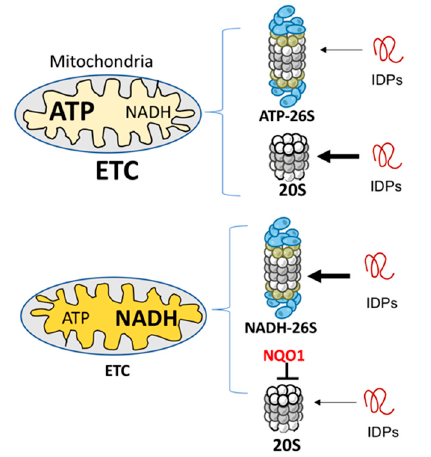
Figure 4. Mitochondria physiology and IDP degradation. Mitochondria with efficient electron transfer chain (ETC) activity ( upper ) generate a high level of ATP and low level of NADH. An opposite picture is obtained with mitochondria with low, or malfunctioning ETC ( lower ). The ATP and NADH levels regulate the formation of different types of 26S PC. Under high levels of NADH, NADH-26S PC is formed that is active in IDP degradation (the thick arrow). However, NADH through NQO1 has a repressive function in inhibiting IDP degradation by the 20S proteasome [42] .